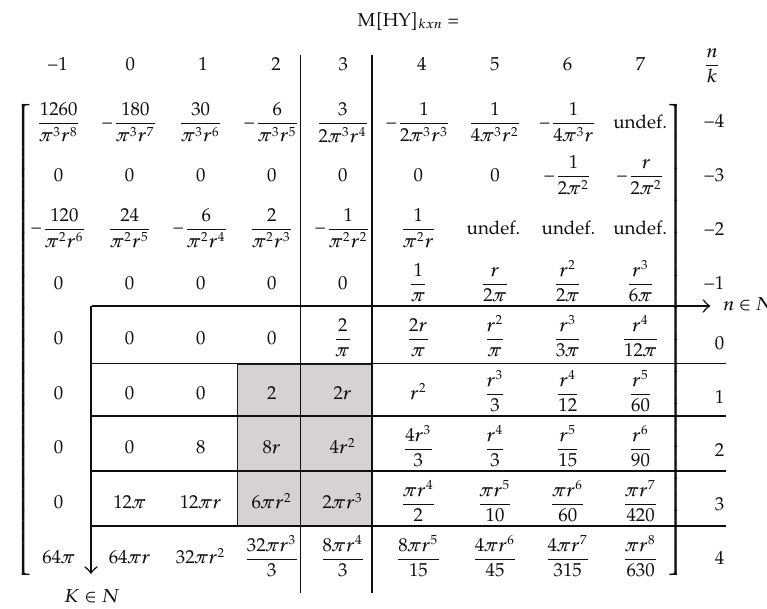
Figure 1: The functional submatrix M (cid:4) HY (cid:2) k,n,r (cid:3)(cid:5) for the freedom degrees k ∈ − 4 , − 3 ,..., 4 and n ∈ − 1 , 0 ,..., 7 and with six characteristics hypercylindrical functions (cid:2) undef. are nondefined, most often singular values of this function (cid:3)